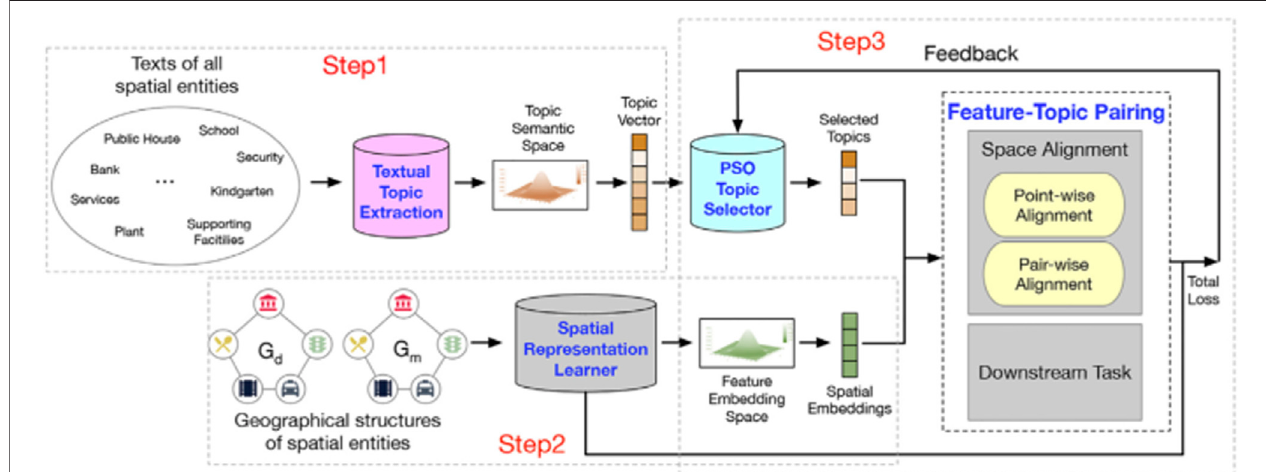
FIGURE 5 | An overview of AutoFTP. In the framework, we fi rst construct a topic semantic space based on the texts of spatial entities. Then, we initialize a embedding feature space based on the geographical structures of spatial entities. Later, we employ a PSO-based framework to conduct feature-topic pairing through jointly optimizing representation learning, point-wise alignment, pair-wise alignment, and downstream task over learning iterations.